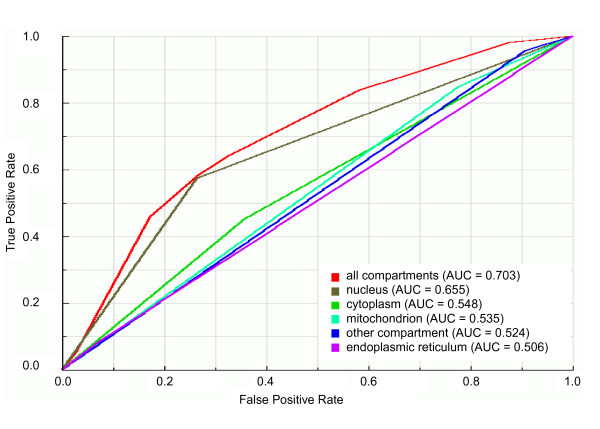
ROC curves and AUC values for the classifiers trained on balanced datasets with individual or grouped cellular compartments. ROC curves and AUC values of classifiers trained on balanced dataset 9 (see Figure 1) with one or all cellular compartments as learning attributes. "all compartments" is the dataset with all cellular compartments as learning attributes; "nucleus", "cytoplasm", "mitochondrion", "other compartment" and "endoplasmic reticulum" are datasets with only the respective cellular compartment as learning attribute.